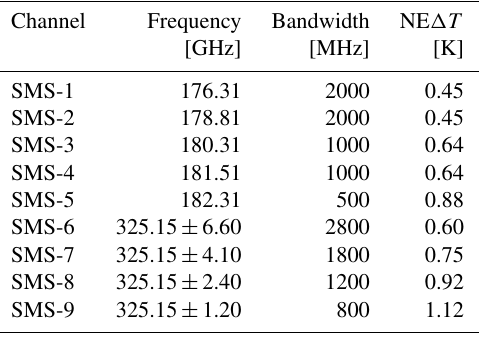
Table 3. Specifications of SMS channels.